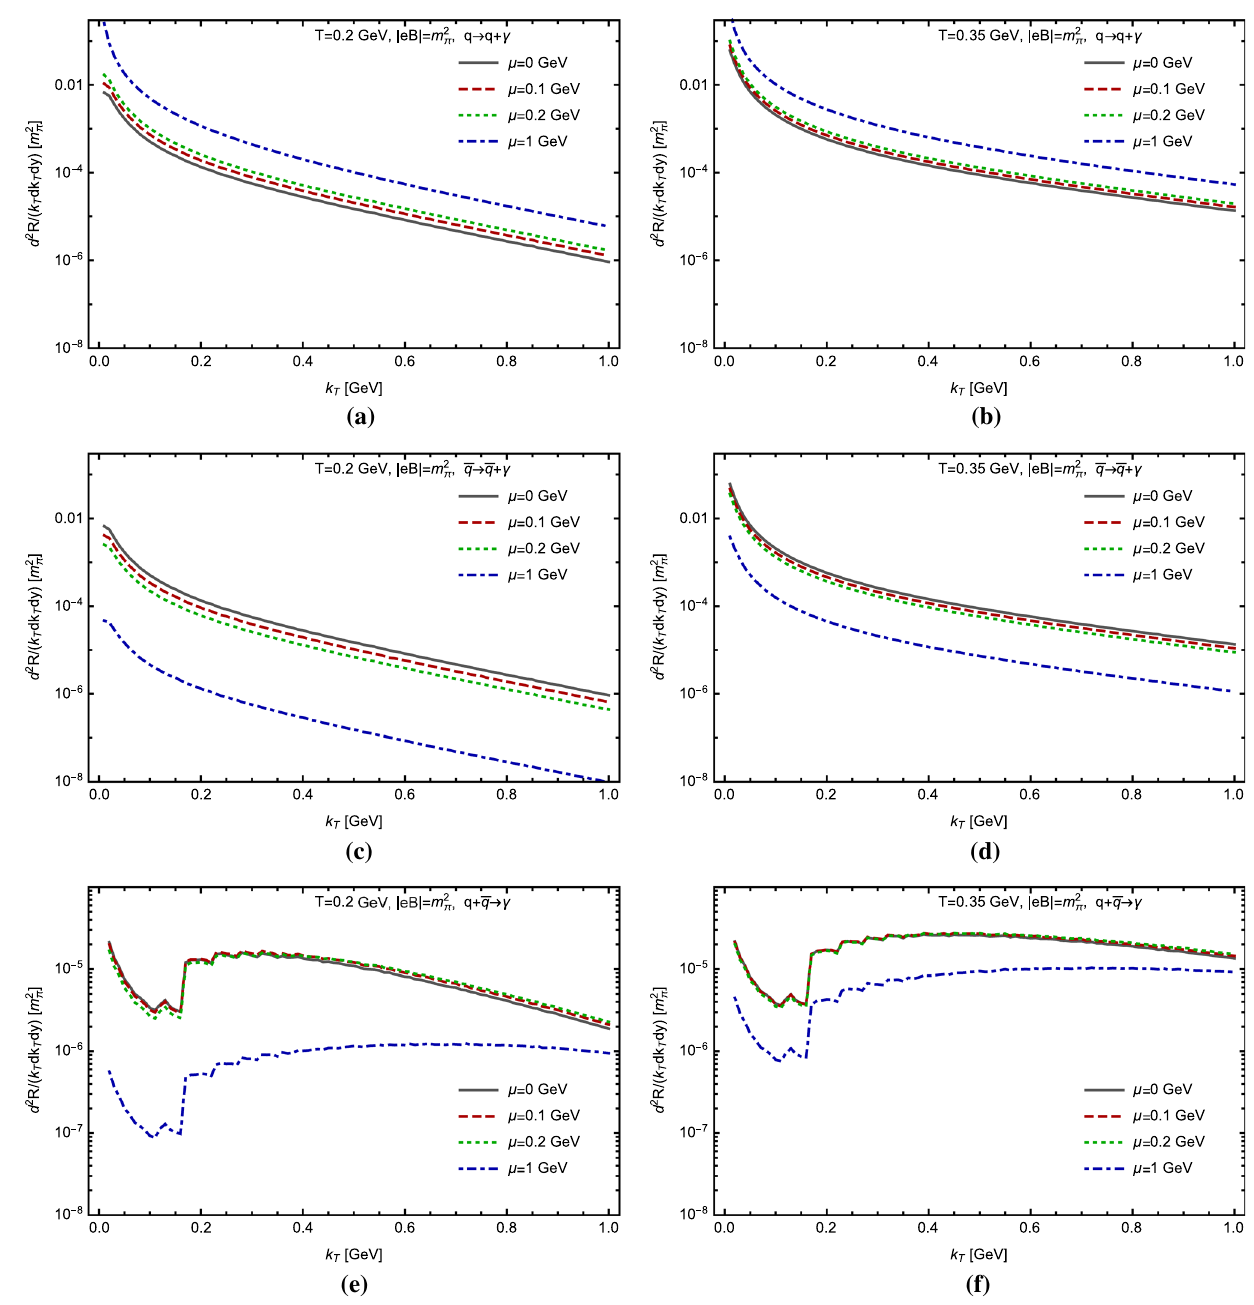
Fig. 3 Partialcontributionsofthethreetypesofprocessestothephoton production rate at | eB | = m 2 π as functions of the transverse momen- tum k T for four different values of the chemical potential: μ = 0 (gray lines), μ = 0 . 1 GeV (red dashed lines), μ = 0 . 2 GeV (green dotted lines), and μ = 1 GeV (blue dot-dashed lines). The left panels ( a , c , e ) show the results for T = 200 MeV and the right panels ( b , d , f )